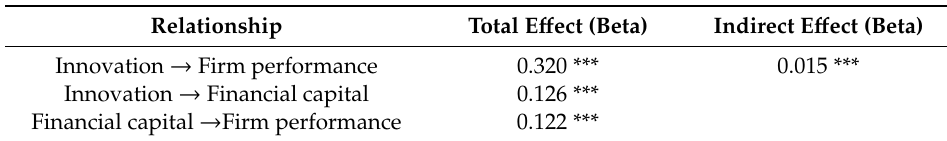
Table 7. Path co-e ffi cient.